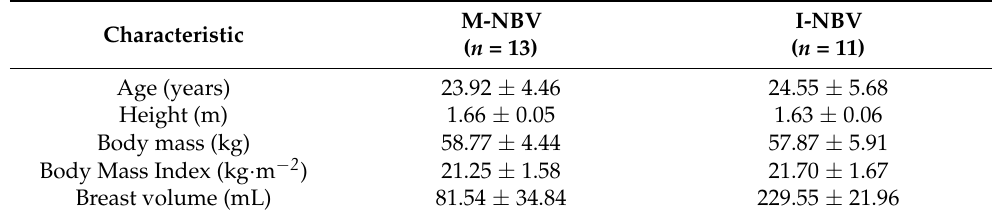
Table 1. The mean ± standard deviations of demographic and anthropometric characteristics of the females with minimal and ideal natural breast